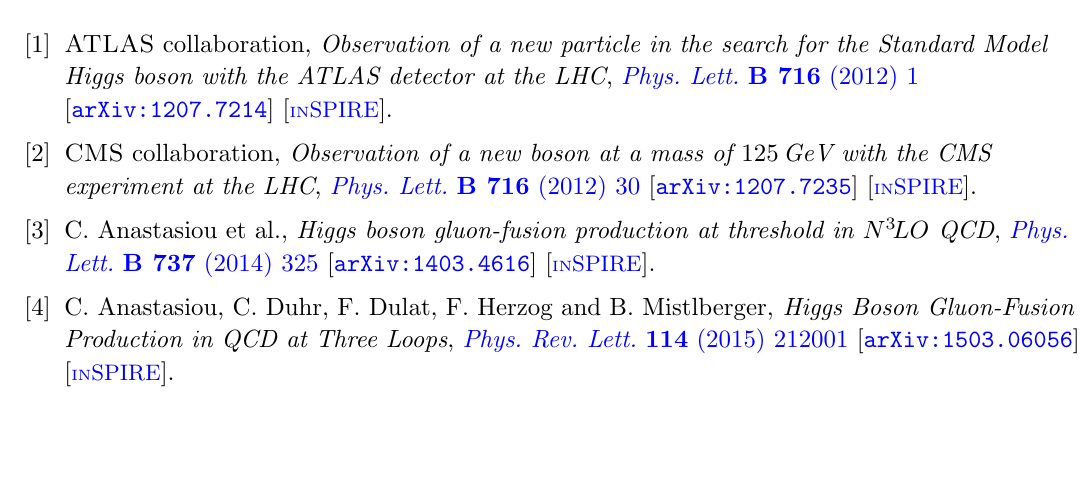
Figure 17 . Comparison between HEJ results with central scale choices (cid:22) (cid:22) r = (cid:22) f = max( m H ; m 12 ). Open